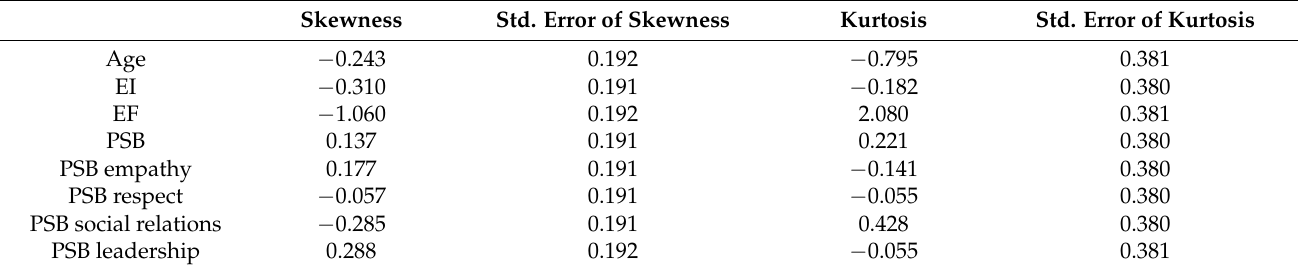
Table 1. Skewness and kurtosis values.